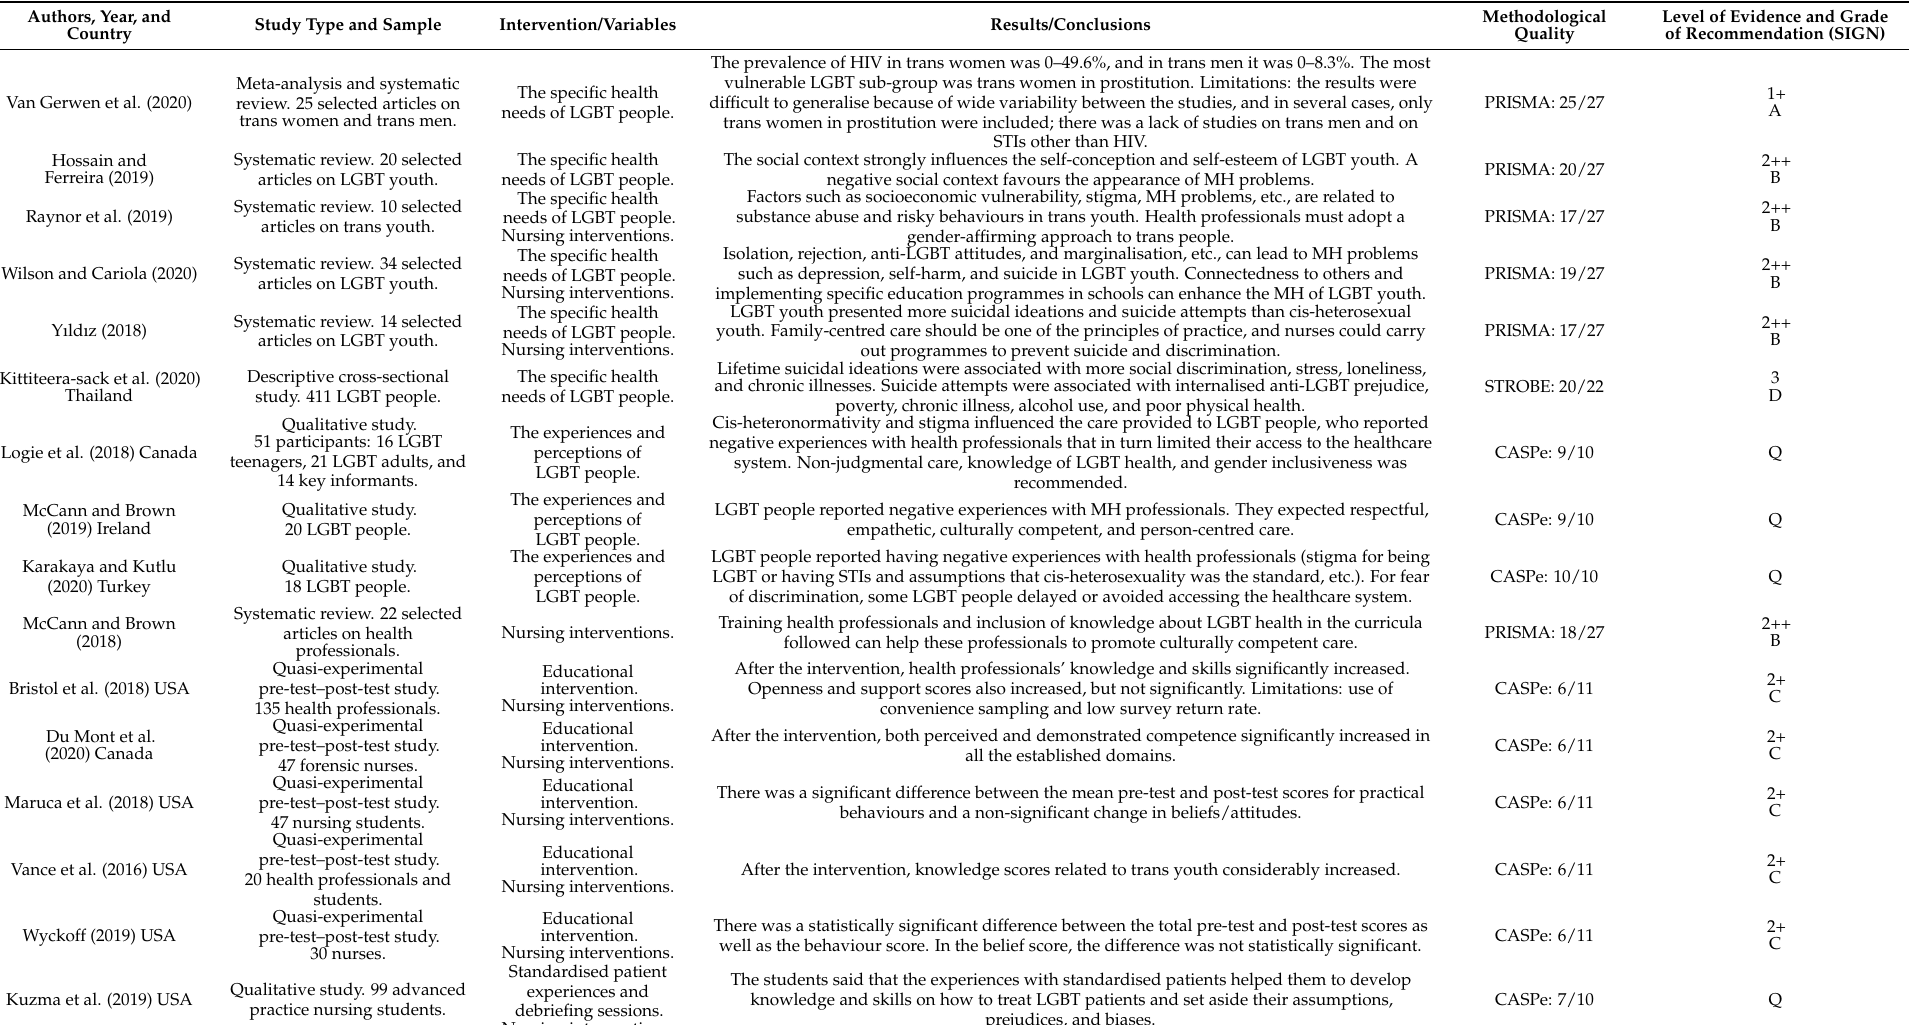
Table 2. Synthesis of the results of the studies included in this